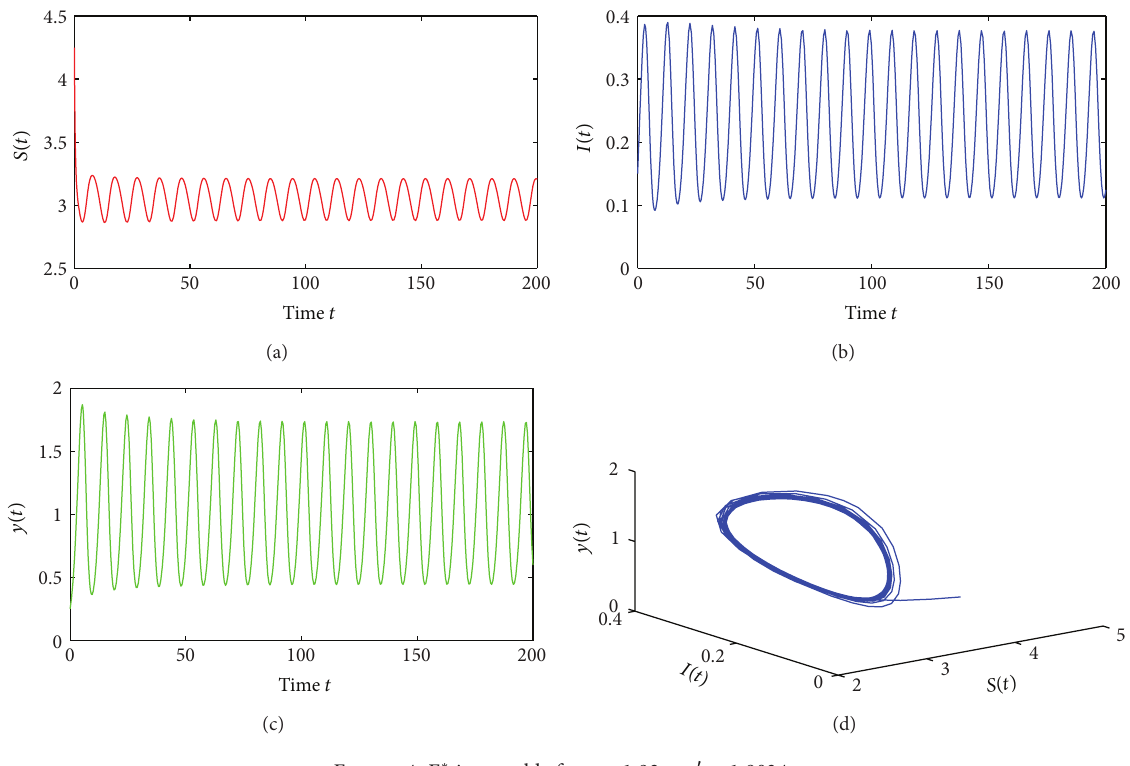
Figure 4: 𝐸 ∗ is unstable for 𝜏 = 1.92 > 𝜏 󸀠 0 = 1.8034